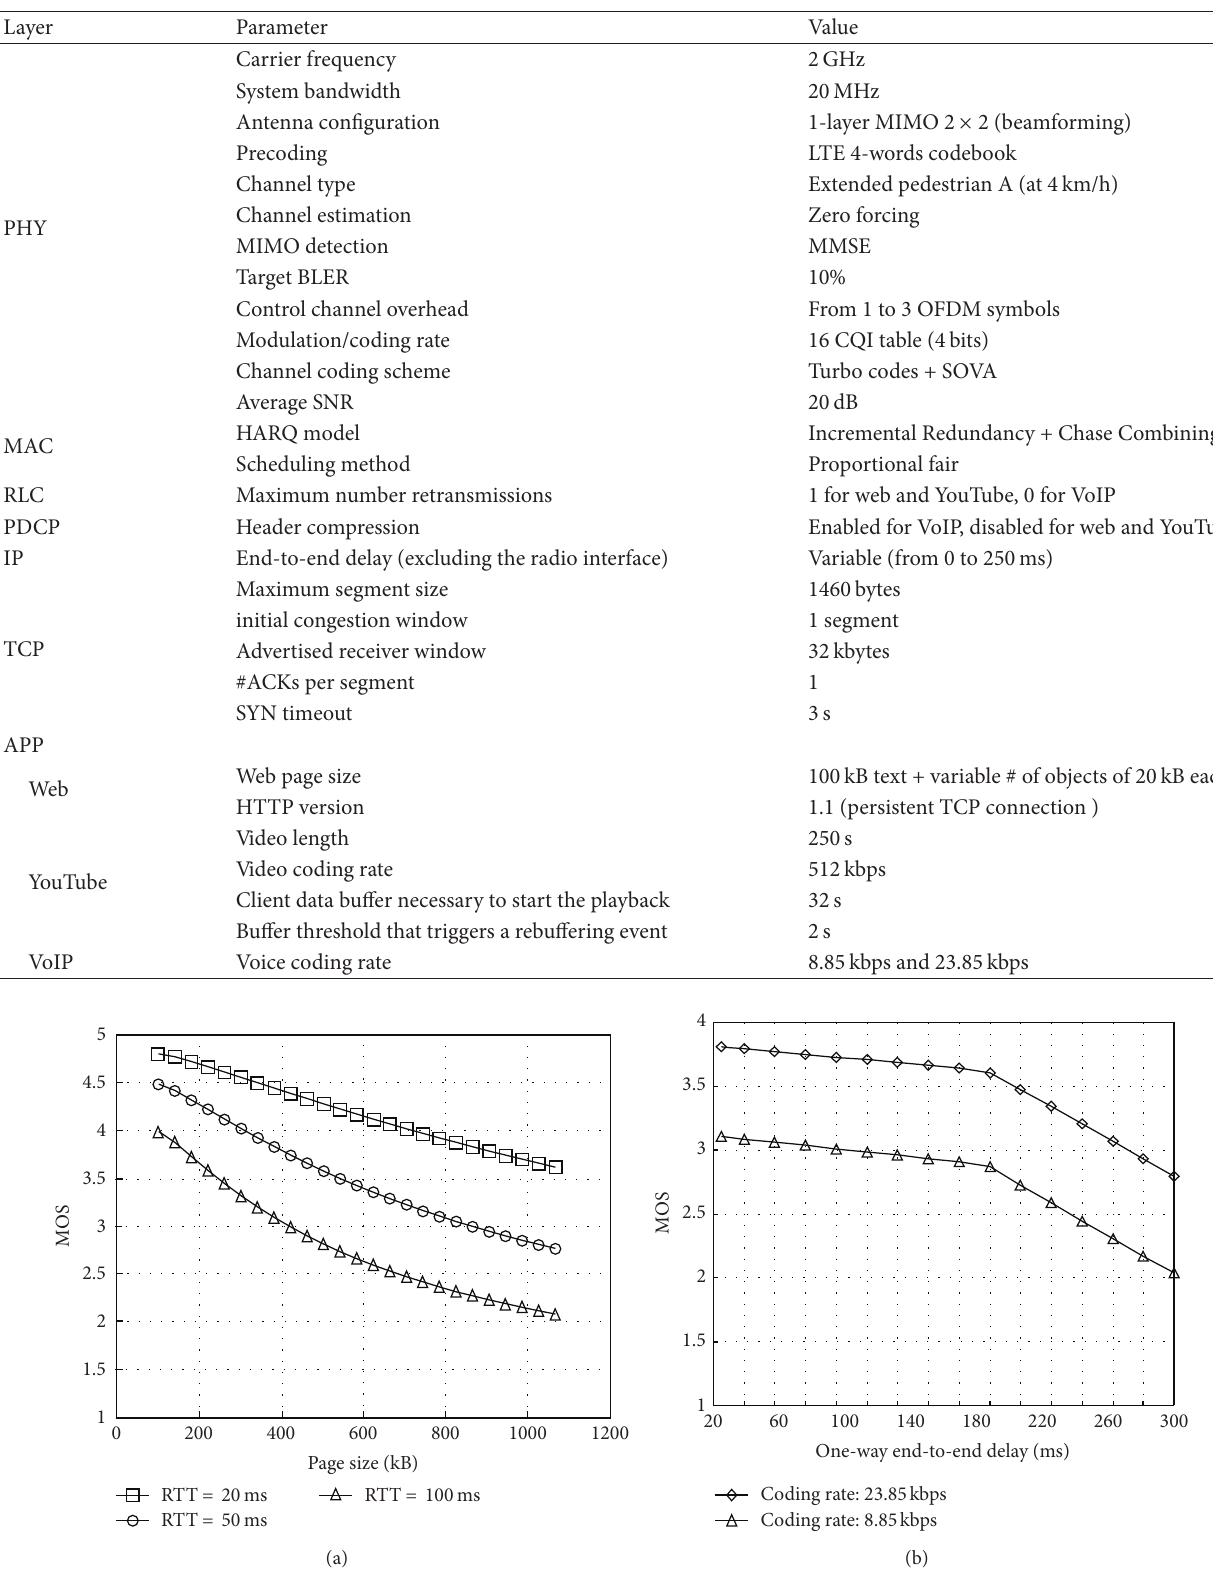
T 3: Con�guration parameters along protocol stack.